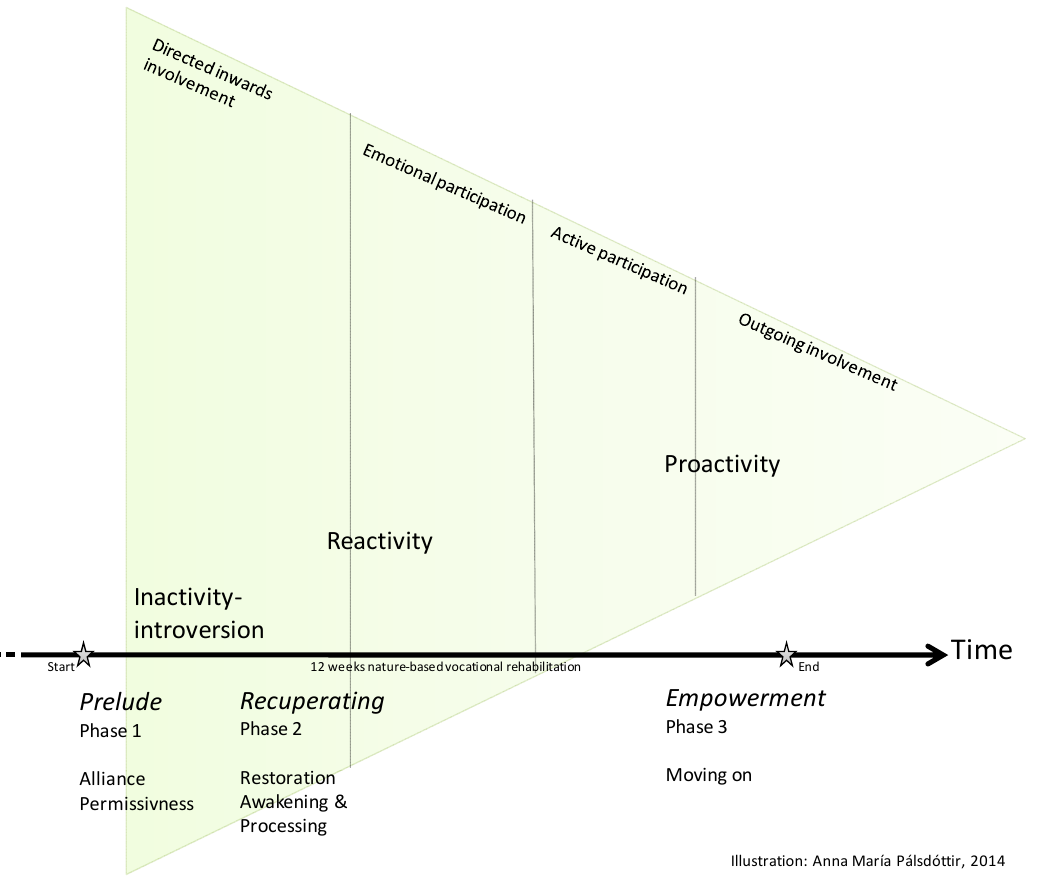
Figure 2. An explanatory model of nature-based rehabilitation that illustrates the three phases of rehabilitation— Prelude , Recuperating and Empowerment —over time, the occupational repertoire (introvert, reactive, and proactive occupations or IRP occupations ) and the SET pyramid of executive functions. The IRP occupations are connected to the different phases of the rehabilitation process, and correspond to the suggested levels of executive functions in the SET